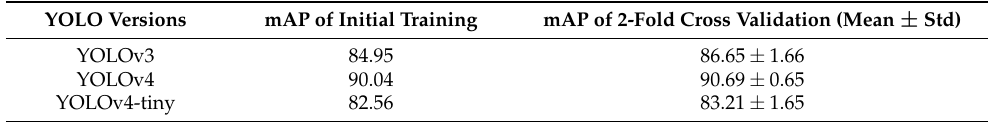
Table 7. Comparison of initial training and two-fold cross validation